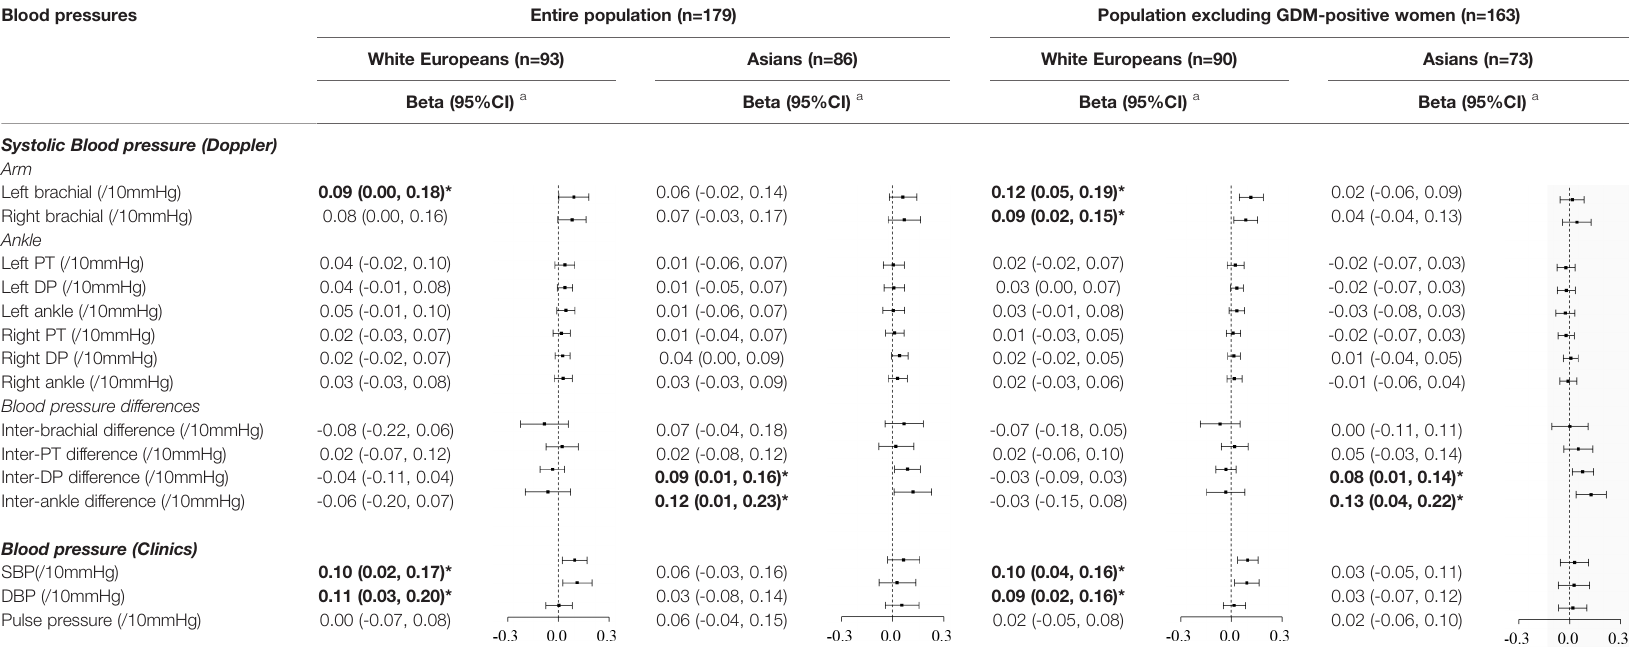
TABLE 2 | The association between blood pressures and fasting blood glucose by